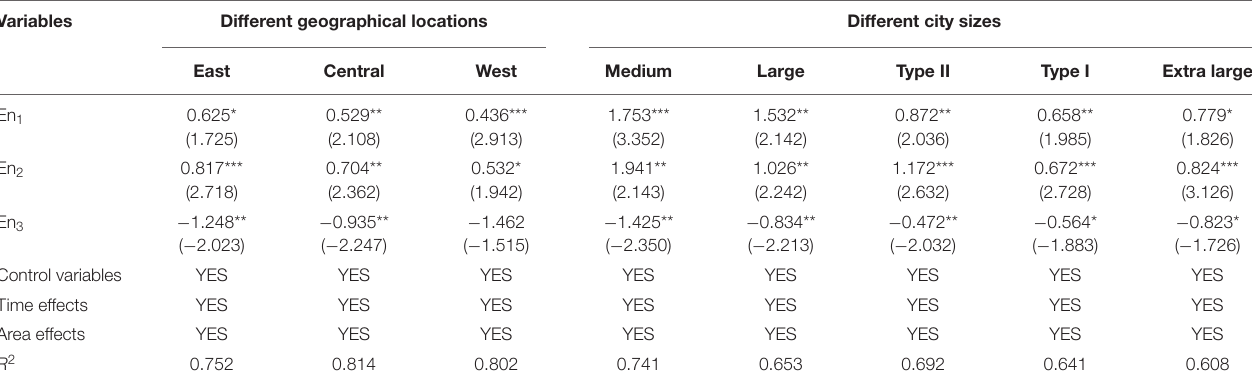
TABLE 6 | Heterogeneity regression results of environmental regulation on urban green innovation.